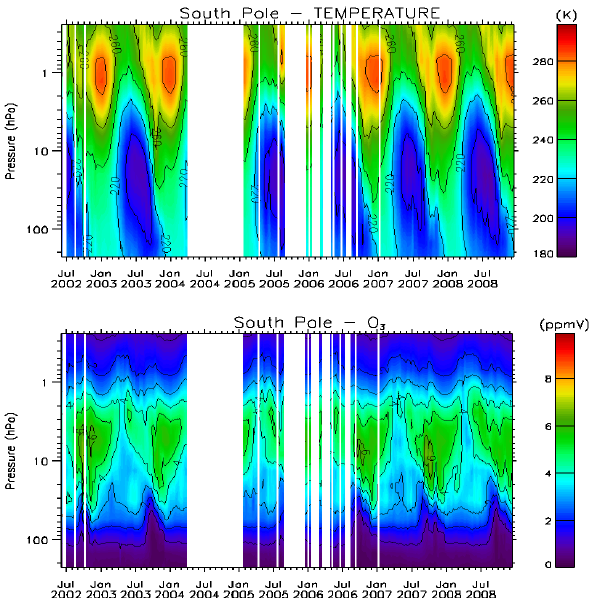
Fig. 14. Time series of 10-days means of temperature and ozone in the Equatorial region (20 ◦ S–20 ◦ N).